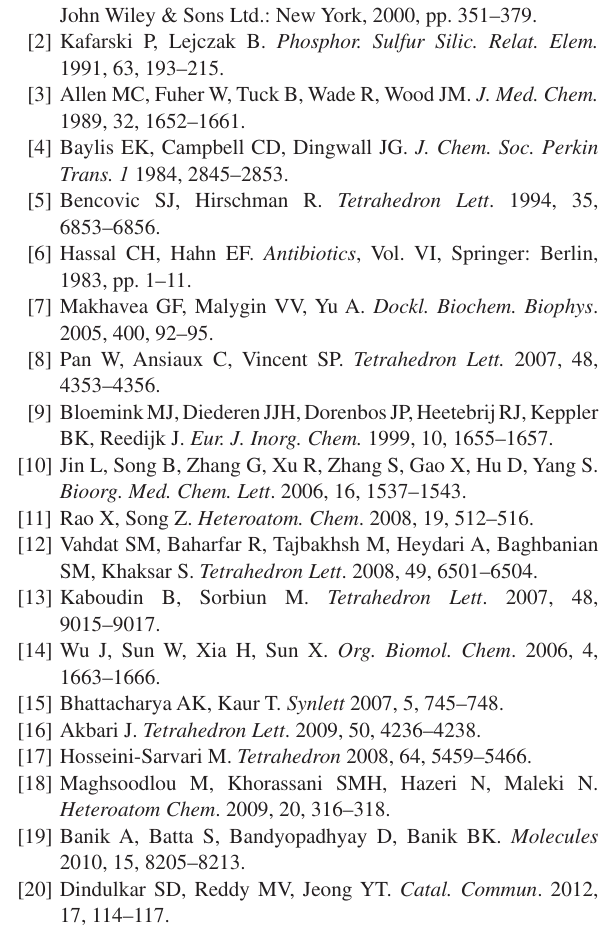
Table 1 Synthesis of α -aminophosphonates in the presence of ZnI